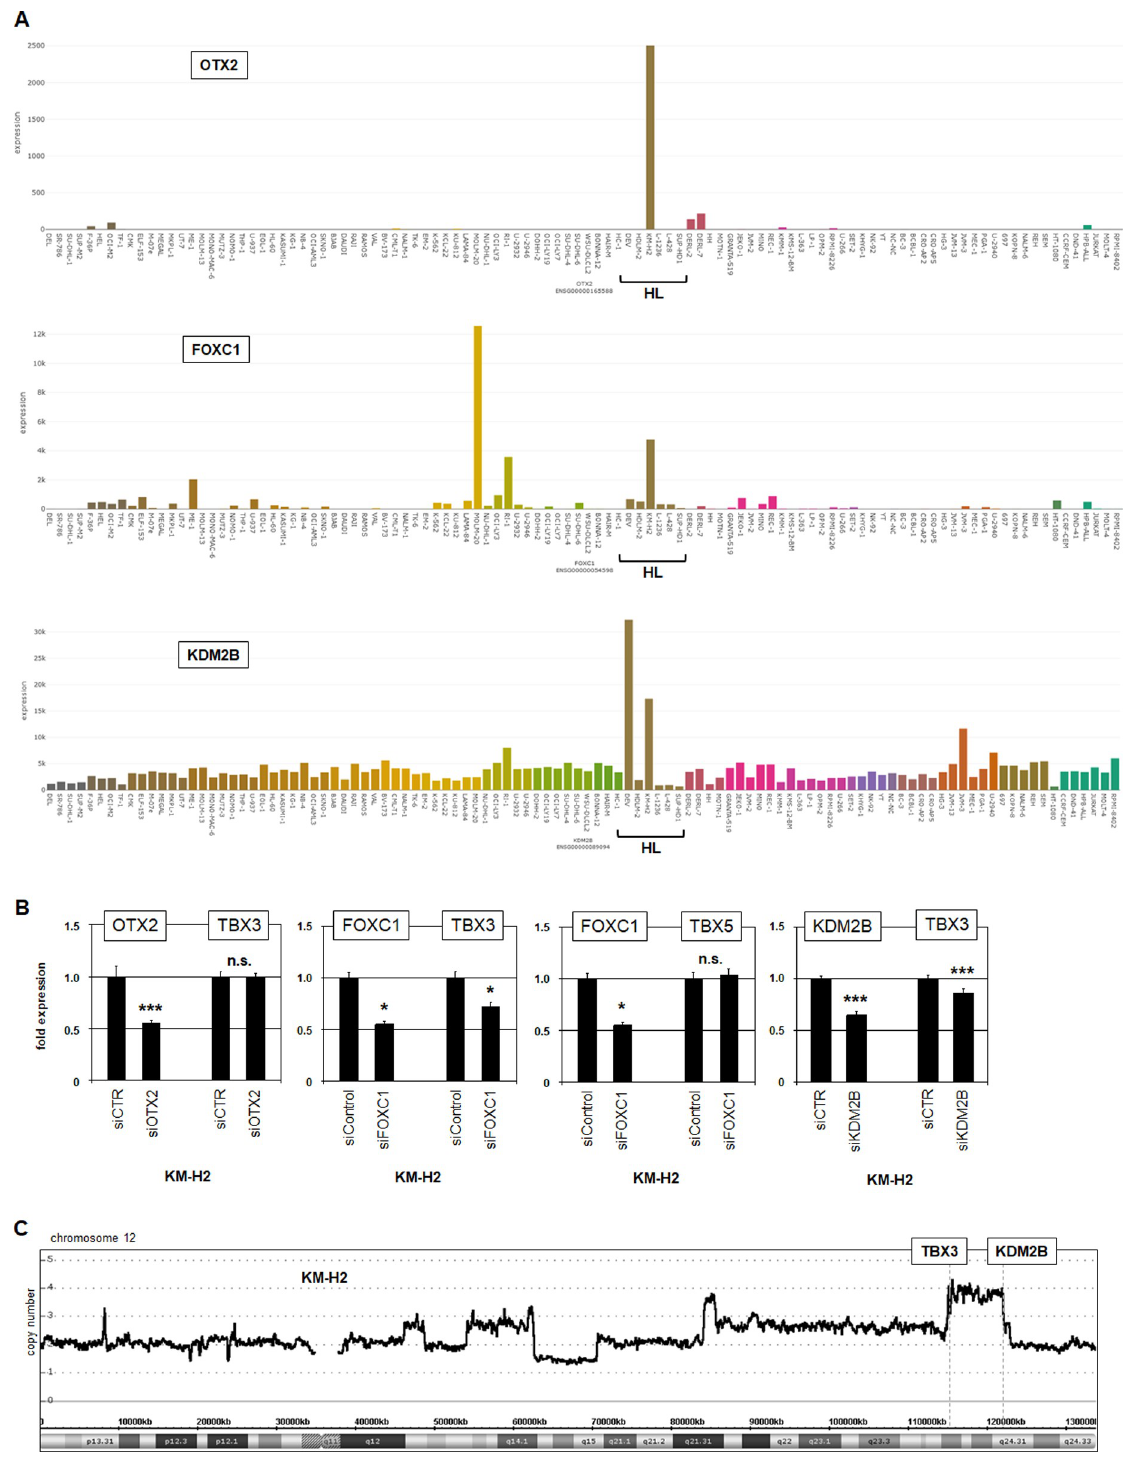
Fig 5. FOXC1 and KDM2B activate TBX3 expression. (A) RNA-seq data from 100 leukemia/lymphoma cell lines (dataset E-MTAB-7721) showing expression of OTX2 (above), FOXC1 (middle), and KDM2B (below). HL cell lines are indicated. Note high transcript levels in HL cell line KM-H2. (B) RQ-PCR analysis of TBX3 and TBX5 after siRNA-mediated knockdown of OTX2, FOXC1, and KDM2B. Data indicated that FOXC1 and KDM2B activated TBX3 while discounting transcriptional impact of OTX2. (C) Genomic profiling data for chromosome 12 of HL cell line KM-H2, demonstrating amplification of TBX3 and KDM2B at 12q24.